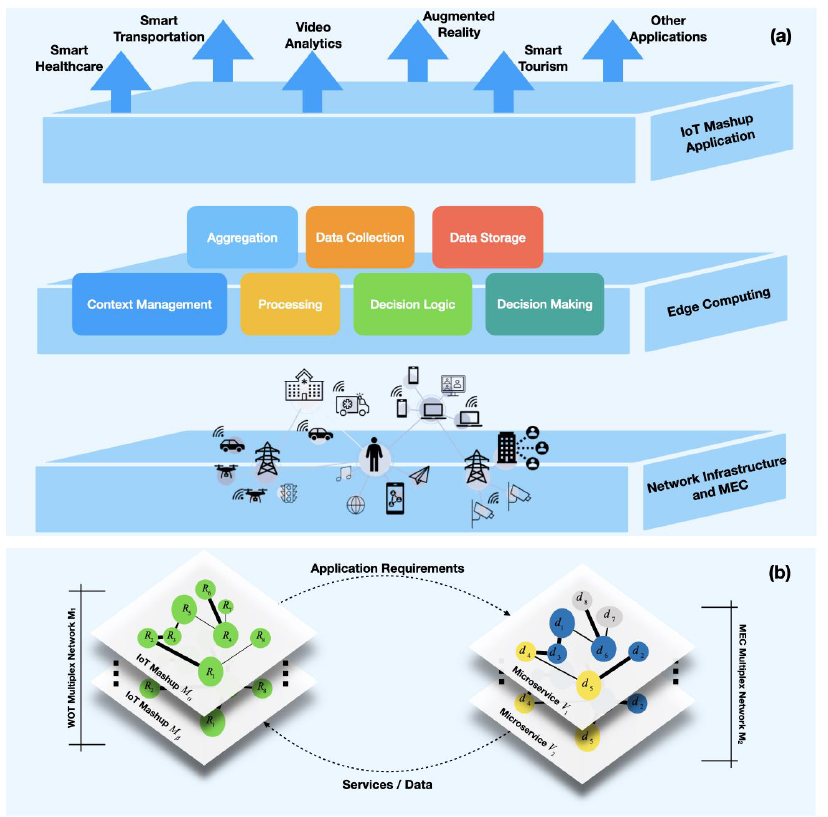
Figure 3. Multiplex network interdependency model (represented in ( b )) for the McLB problem (synthesized in ( a